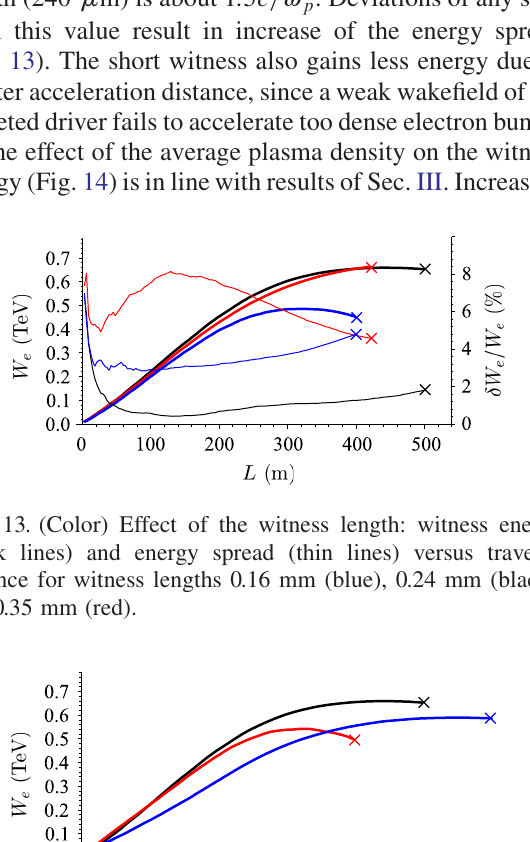
FIG. 15. (Color) Effect of the witness charge: (a) witness energy growth for various witness-to-driver charge ratios; (b) efficiency of driver-to-witness energy transfer as a function of witness